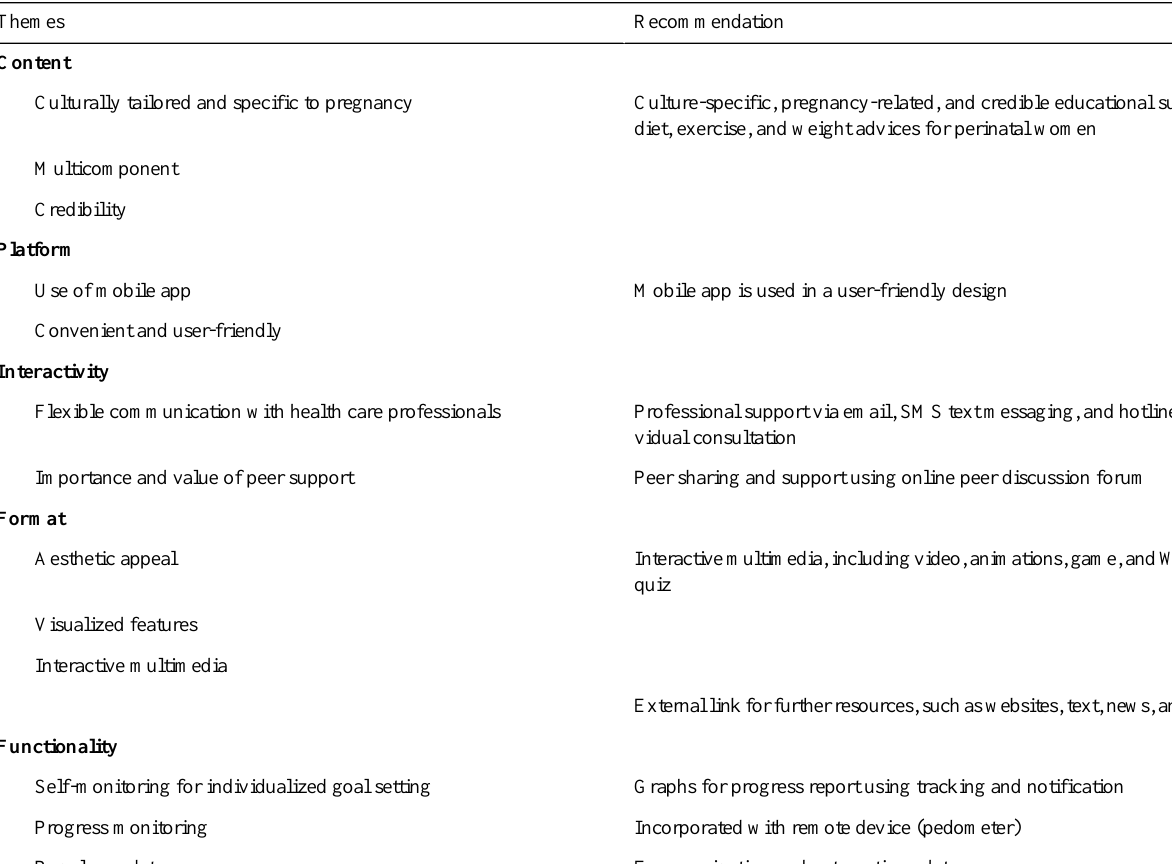
Table 3. Key themes, subthemes, and recommendations. SMS: short message